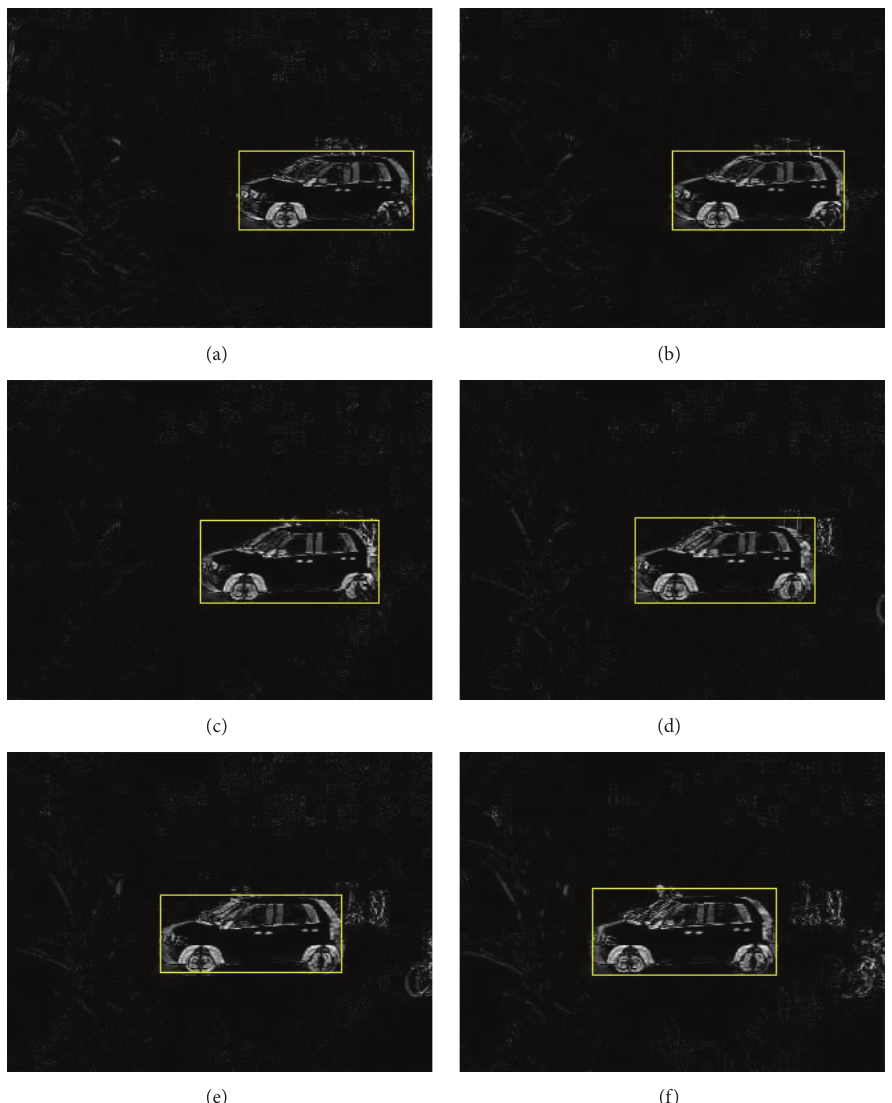
Figure 10: Tracking a moving car using matched corner points by FAB descriptor; DOI are showing the new location of the moving